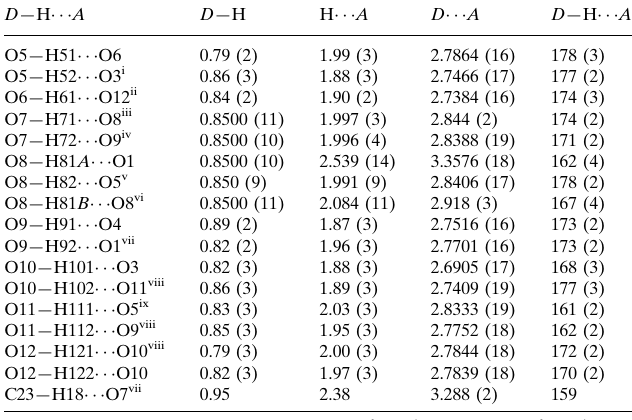
Hydrogen-bond geometry (A˚ , (cid:2)